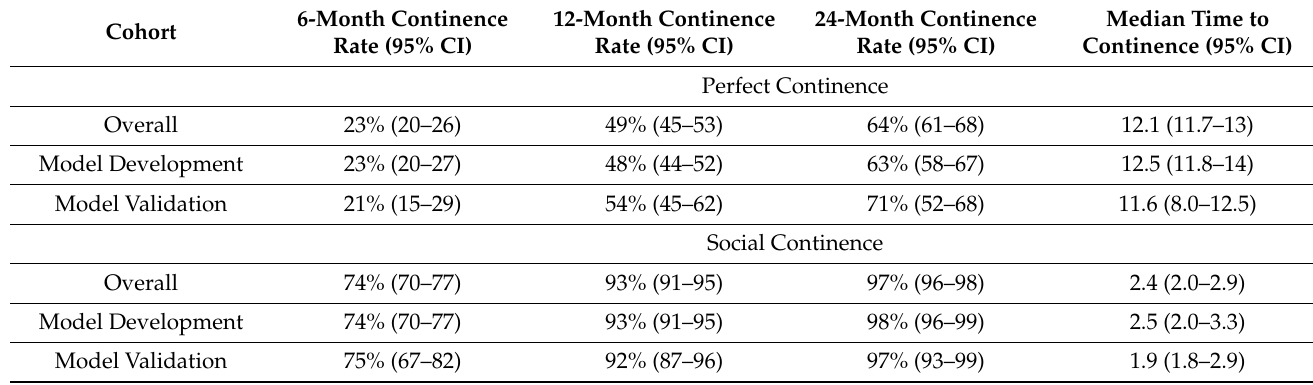
Table 2. Rate and Time to